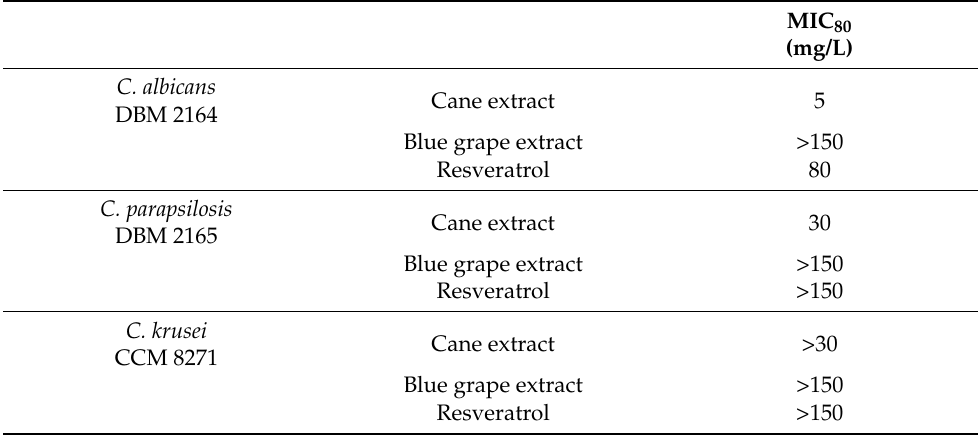
Table 1. Minimum inhibitory concentrations (MIC 80 ) of blue grape extract, cane extract and